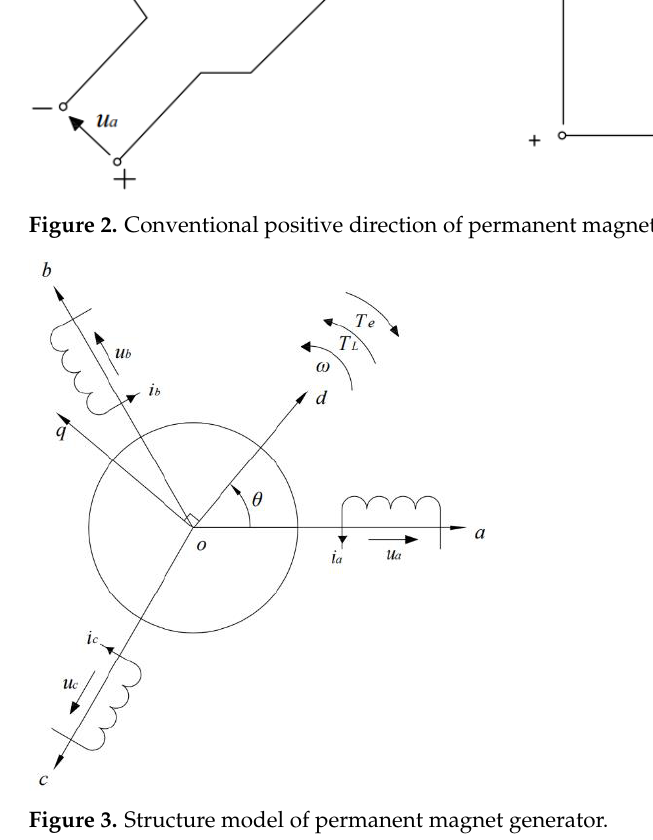
Figure 3. Structure model of permanent magnet generator.